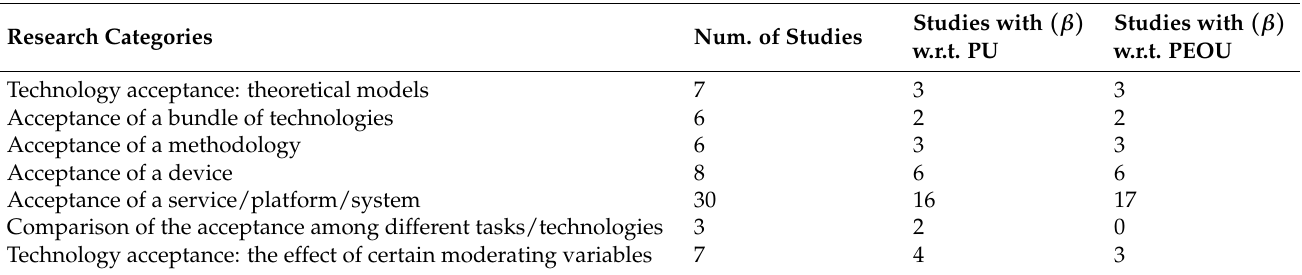
Table 4. Number of papers reporting path coefficients ( β )